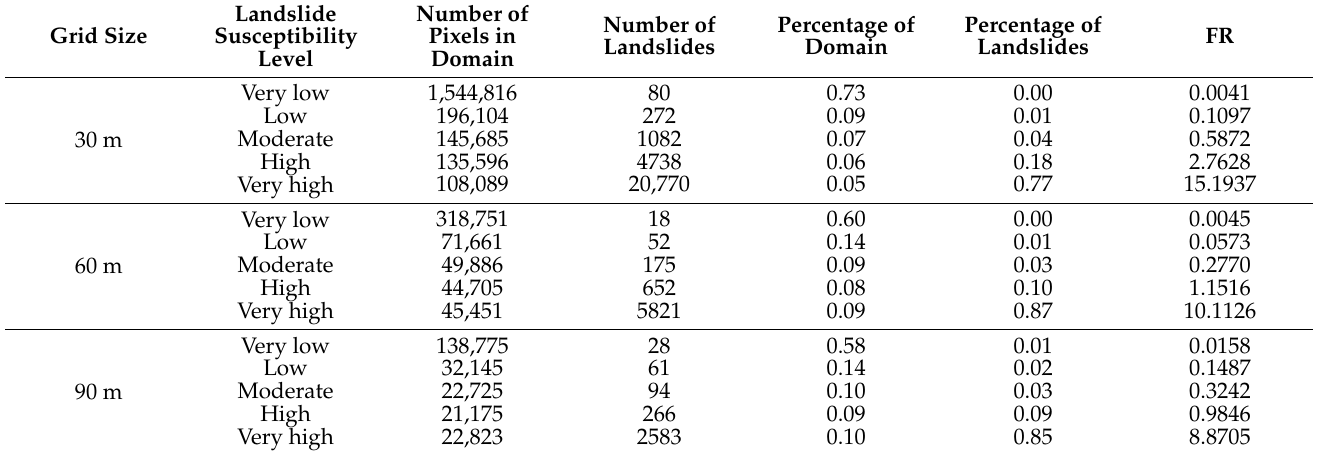
Table 4. XGBoost zoning model of landslide susceptibility.